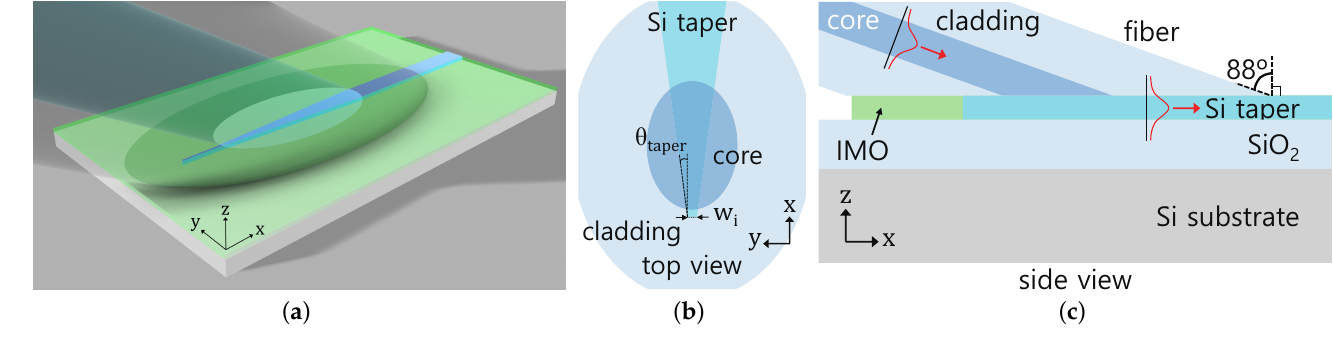
Figure 1. Simulation geometry. ( a ) Artistic view of proposed structure. ( b ) Top-down view of proposed structure. W i is the width of the taper tip and θ taper is the half angle of the taper. ( c ) Side view of proposed structure. IMO: Index matching oil, Si taper: silicon taper. The proportion of the structure is exaggerated for a clear